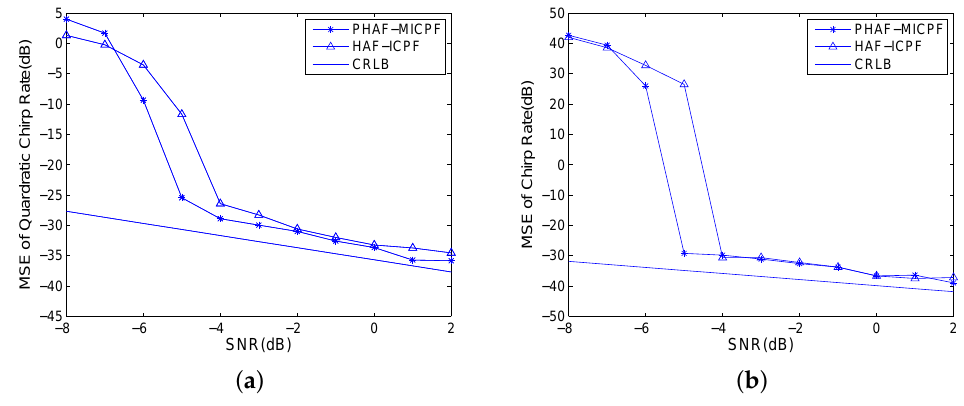
Figure 8. Anti-noise performance analysis: ( a ) MSEs of QCR; and ( b ) MSEs of CR.